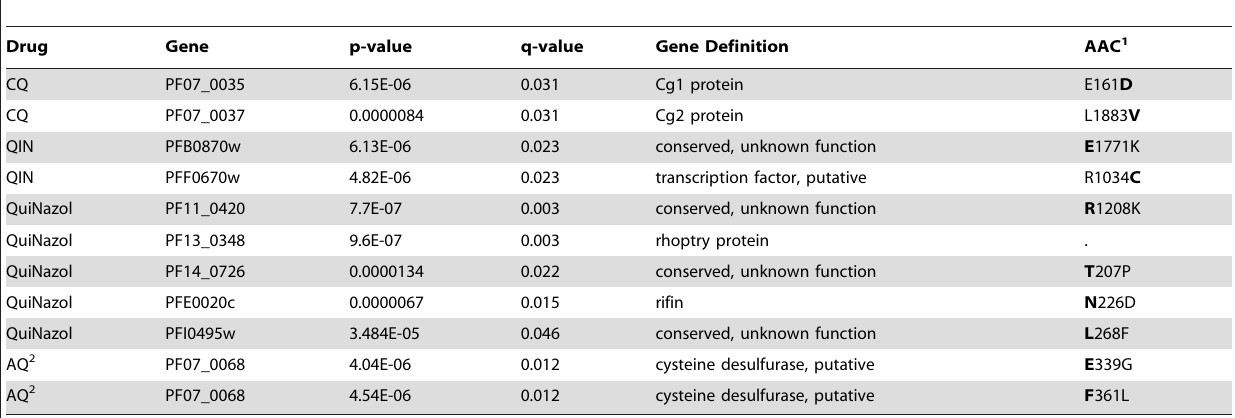
Table 1. SNPs achieving significance (q-value , 0.05) after correcting p-values for multiple hypothesis